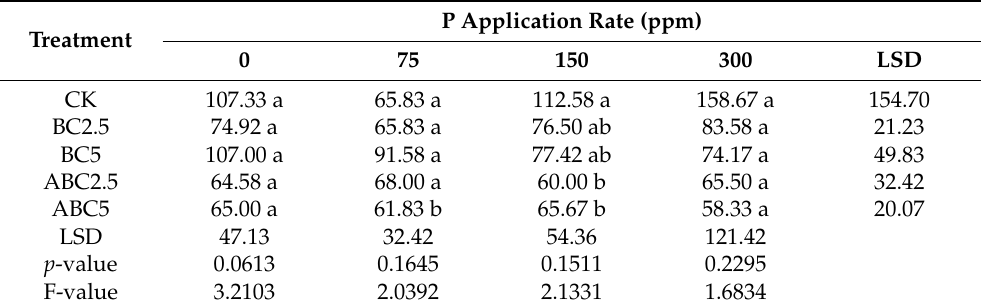
Table 12. Effects of BC and ABC applied at different rates with different P fertilizer application rates on Plant Mn concentration